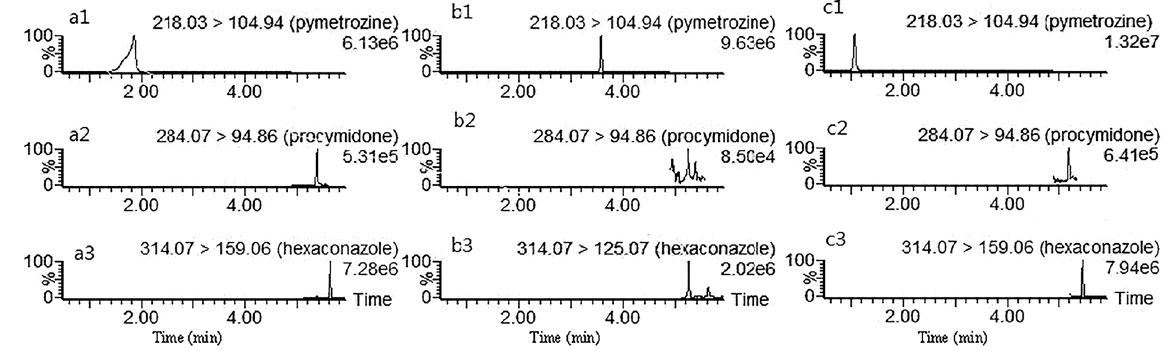
Figure 2. MRM chromatograms of matrix standard solutions at 10 μ g/l generated with 0.1% formic